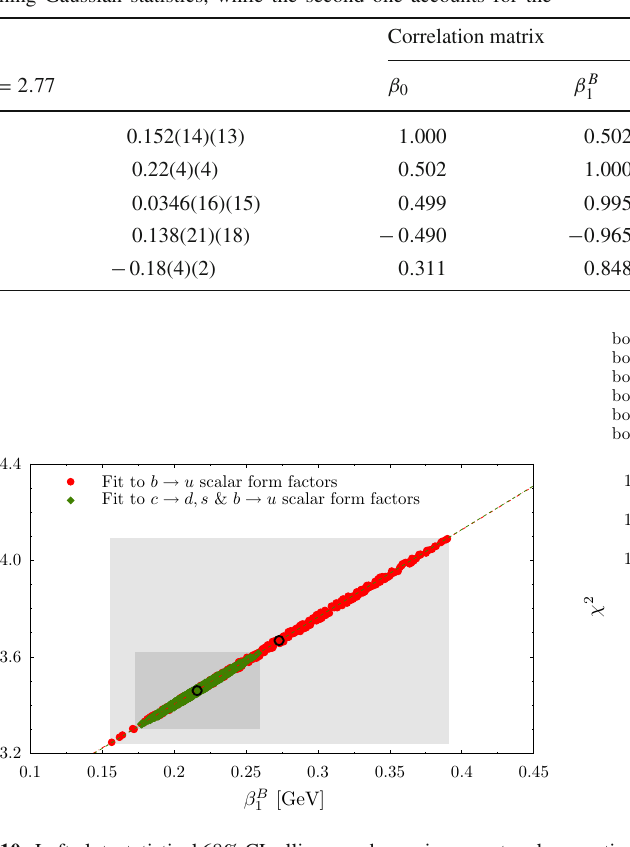
and β B through 1 2